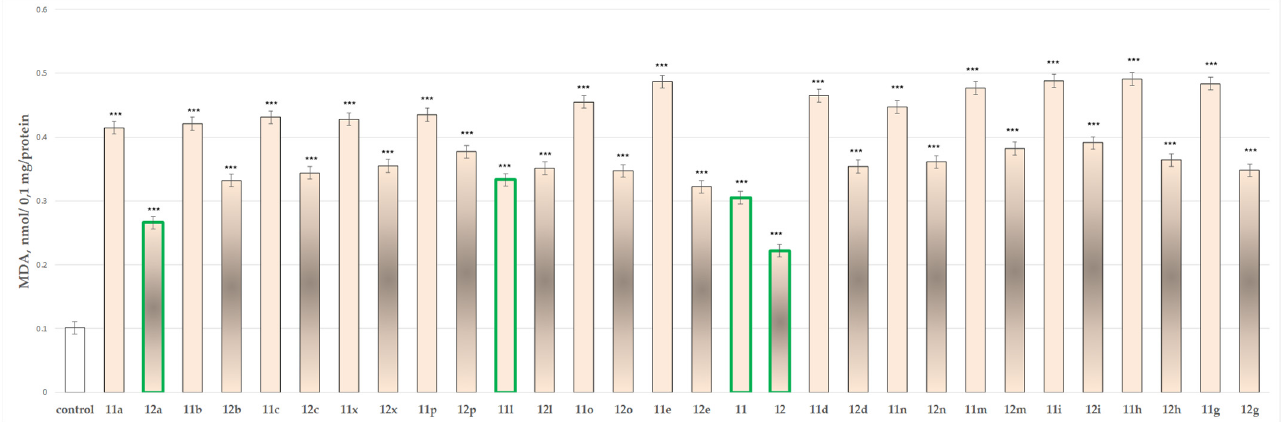
Figure 8. Effects of compounds 11, 11a – 11x, 12 and 12a – 12x (100 μ mol), applied alone, on MDA production in isolated rat brain microsomes. *** p < 0.001 against the control (untreated microsomes). The green outline indicates the most promising derivatives.